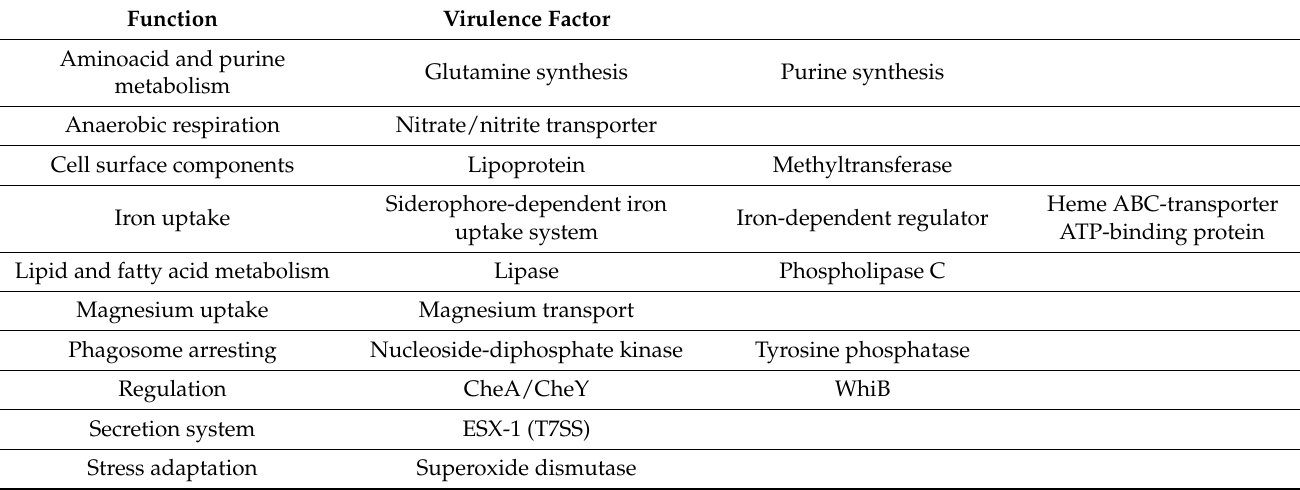
Table 2. Virulence factors in the core genome of Arcanobacterium phocae